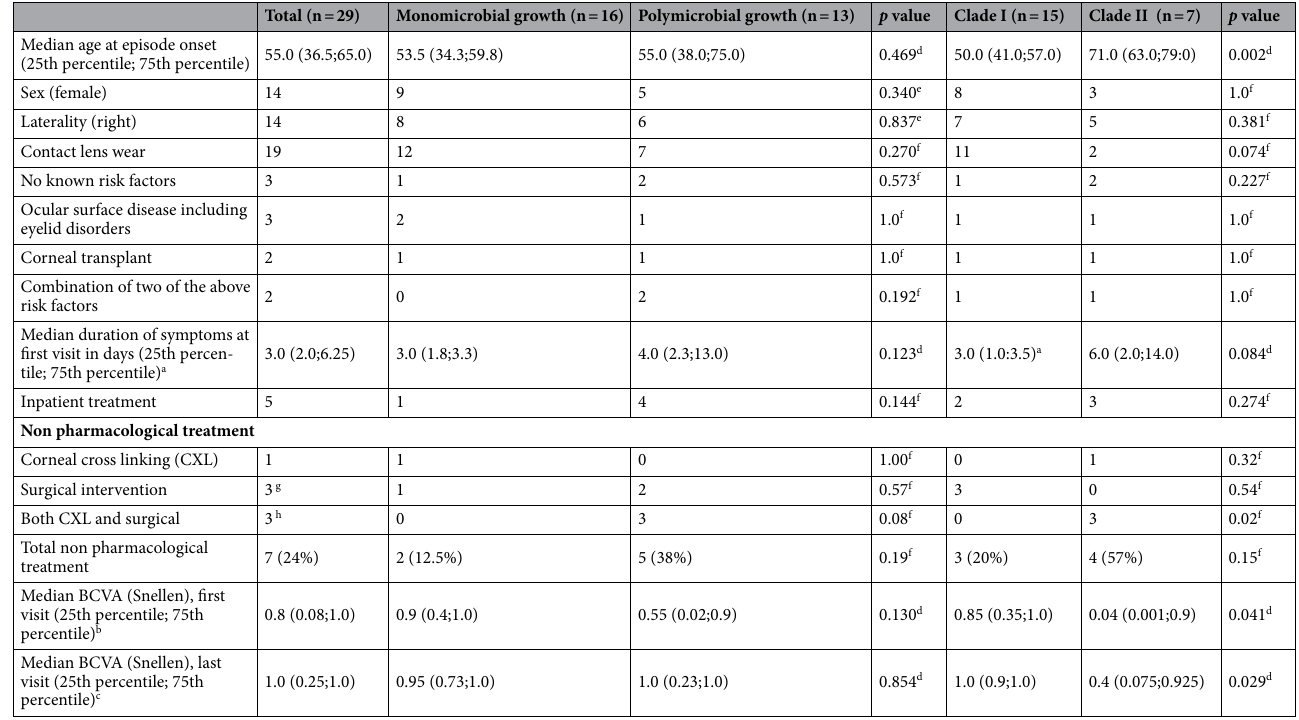
Table 1. Clinical characteristics of patients with Corynebacterium macginleyi -associated infectious keratitis, January 2004 to June 2018. a = 3 patients with no information on duration of symptoms (2 with monomicrobial growth, 1 with polymicrobial growth). b = 1 patient with polymicrobial growth information missing on BCVA at first visit. c = 2 patients with monomicrobial growth information missing on BCVA at last visit. d = Mann– Whitney U-test, 2-tailed. e = chi 2 test, 2-sided. f = Fisher’s exact test, 2-sided. g = 2 patients received an